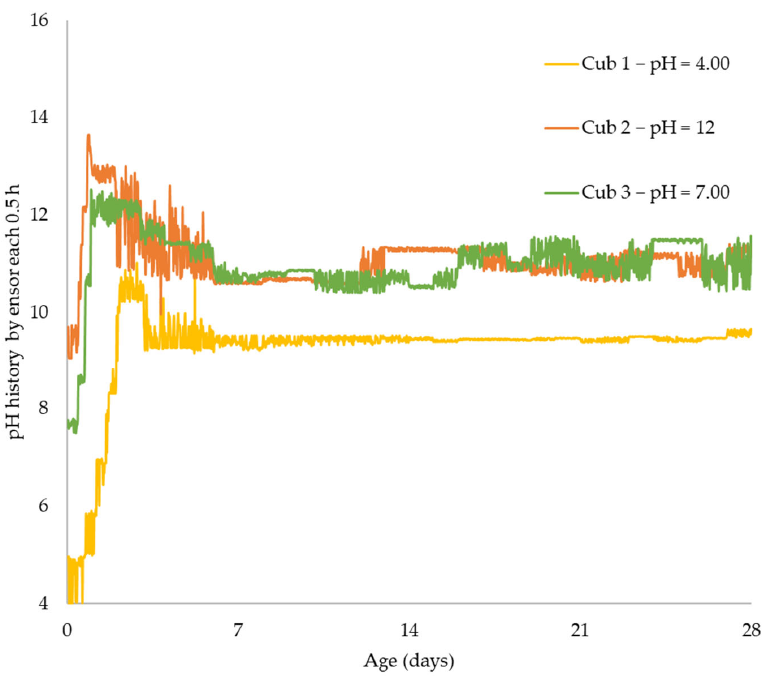
Figure 3. pH data with time recorded by the sensor after every 0.5-h time interval.